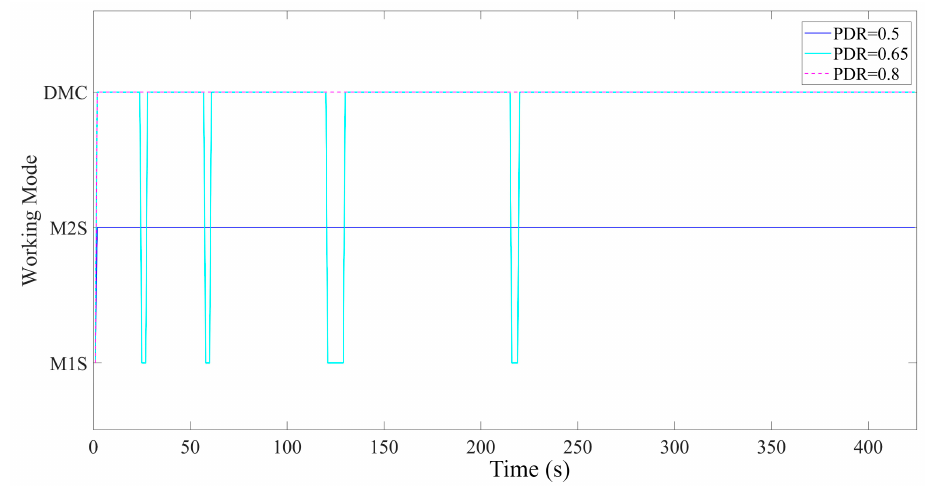
Figure 8. Working mode of the DICPS.